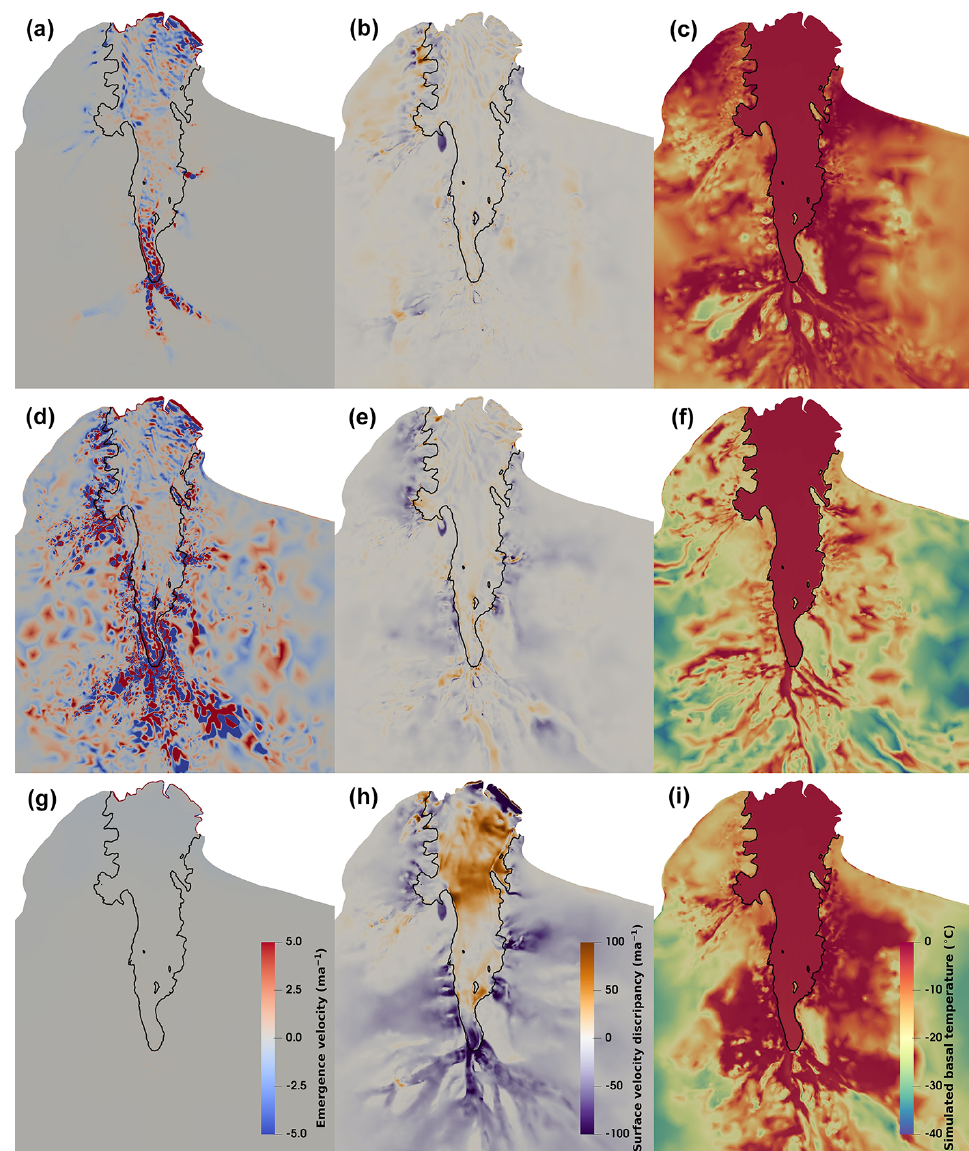
Figure A1. The surface emergence velocity (a, d, g) , surface horizontal velocity discrepancy (b, e, h) and simulated basal temperature (c, f, i) for simulations E5_c1 (a, b, c) , E5_ns (d, e, f) and E5_di (g, h, i) of Gladstone and Wang (2022). The emergence velocity is the surface ice velocity component in the outward normal direction. The surface velocity discrepancy is the difference between simulated and observed surface horizontal